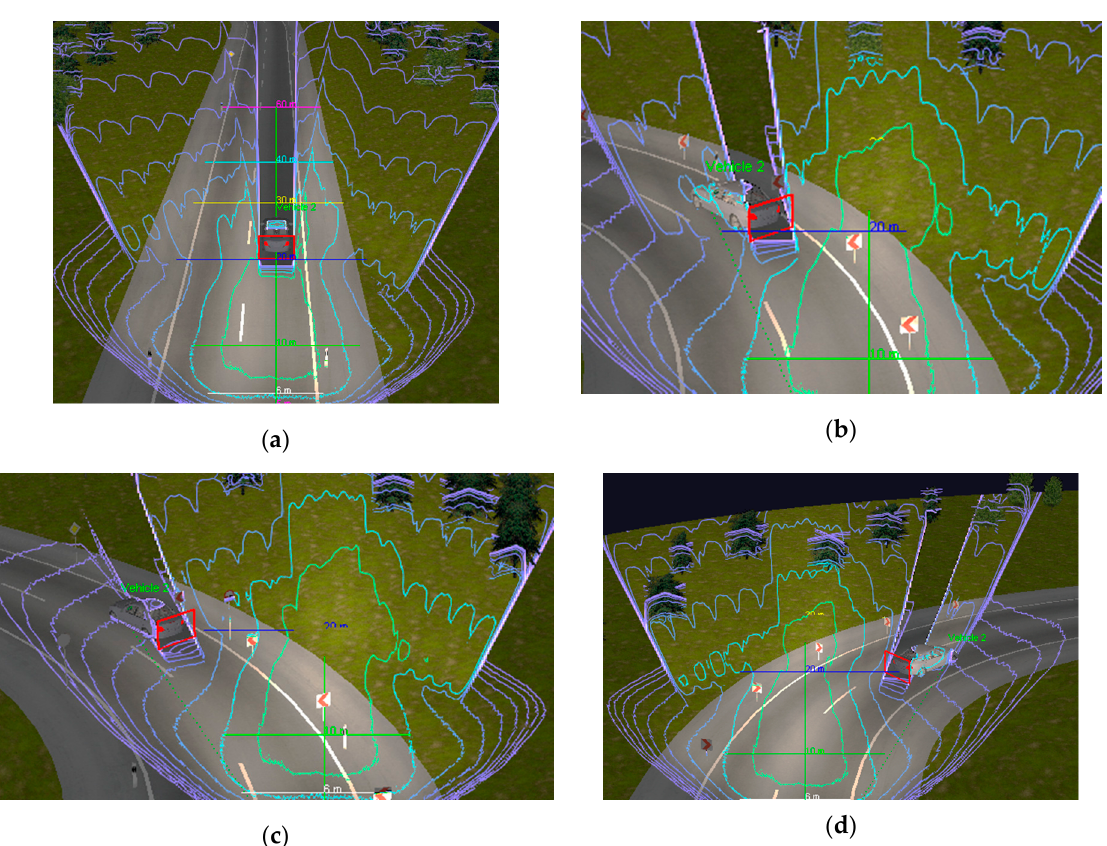
Figure 9. S-curve with 25 m curvature simulation at 100% non-glare zone width: ( a ) At the beginning of the simulation, the vehicle travels on a straight road, and no glare is created. ( b ) When the vehicle enters the corner, glare is created, corresponding to the first peak in Figure 8. ( c ) When the stimulus vehicle exits the high beam area, there is a short time when glare drops to zero, corresponding to the area between two peaks in Figure 8. ( d ) Light penetrates through the vehicle body due to the limitation of the simulator, which is shown as the third peak in Figure 8 and is neglected as an error. In accordance with the NHTSA ADB testing proposal [22] and the SAE standard ADB testing procedure [26] and for the same direction driving scenario at a distance shorter than 60 m, lux readings above 18.9 lx are considered to be glare, which is the dashed line in Figure 8. In this project, the total time during a simulation when the lux reading is above 18.9 lx is considered as the glare rating for this driving scenario and will be used as an input in the fuzzy logic controller to find the best non-glare zone